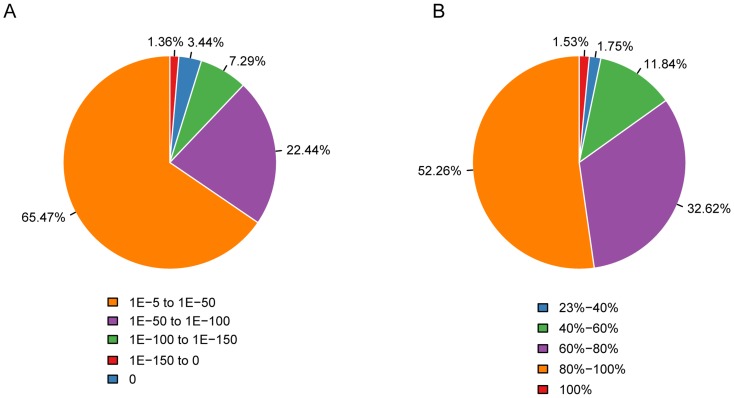
Characteristics of sequence homology of D. latiflorus unigenes BLASTED againsta GenBank databases.A. E-value distribution of BLAST hits for matched unigene sequences, using an E-value cutoff of 1.0E-5. B. Identity distribution of top BLAST hits for each unigene.